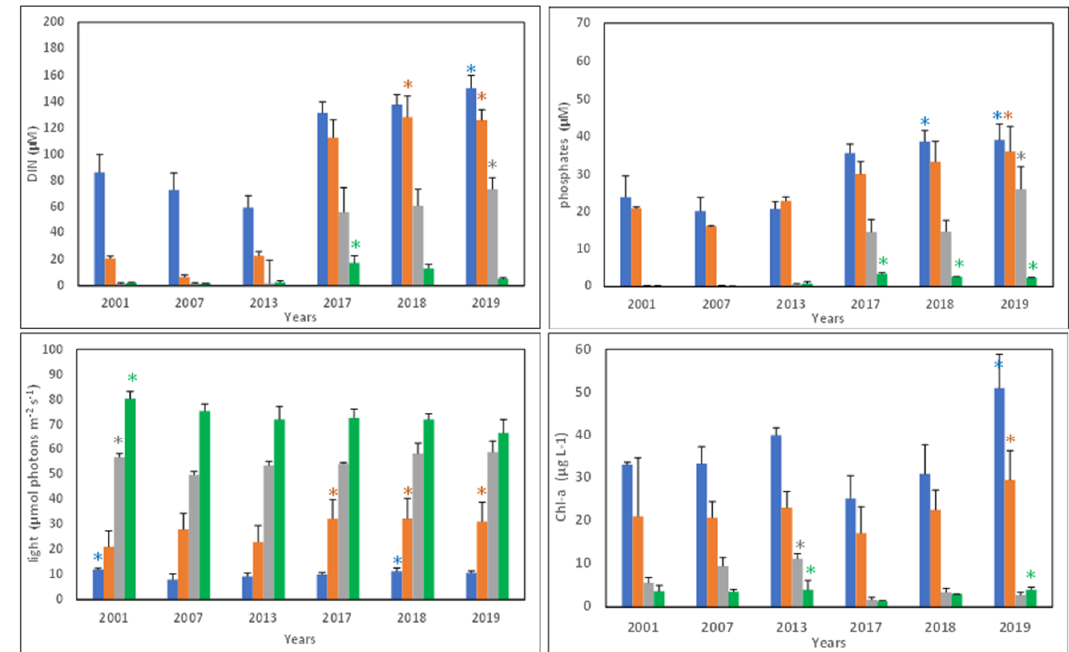
Figure 2. Mean and standard deviations of dissolved inorganic nitrogen (DIN) (upper left), phosphates (upper right), light (lower left), and chlorophyll-a (Chl-a) (lower right) in Jakarta Bay, 2001–2019. Notes: Blue color is for river mouth stations; orange color is for inner part of the bay stations; grey color is for middle part of the bay stations, and green color is for outer part of the bay stations. (*) are the highest mean of river mouths (blue), inner part (orange), middle part (grey), and outer part (green) of the bay stations.